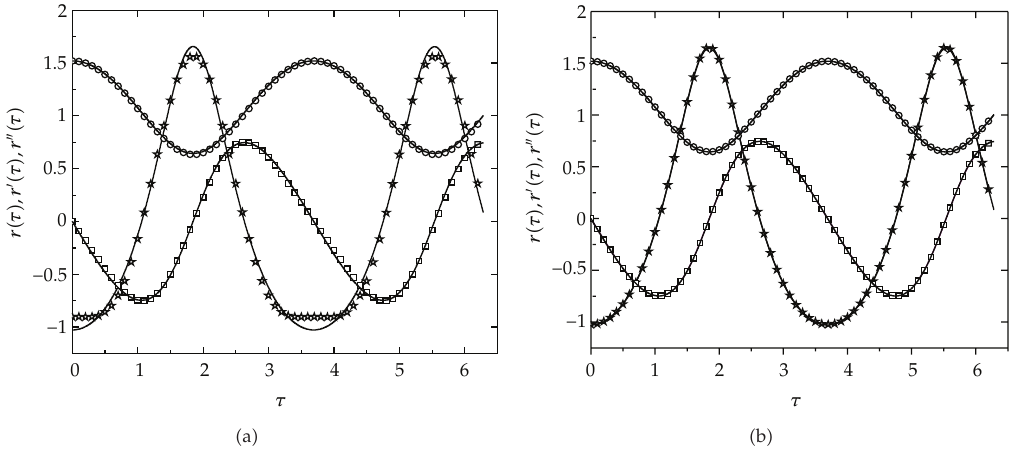
Figure 4: Comparison between HAM approximations (cid:3) hollow symbols (cid:4) and Runge-Kutta numerical solutions (cid:3) solid lines (cid:4) for r (cid:3) τ (cid:4) (cid:3) circles (cid:4) , r (cid:6) (cid:3) τ (cid:4) (cid:3) squares (cid:4) , and r (cid:6)(cid:6) (cid:3) τ (cid:4) (cid:3) stars (cid:4) ; (cid:3) a (cid:4) 2nd-order approximation, (cid:3) b